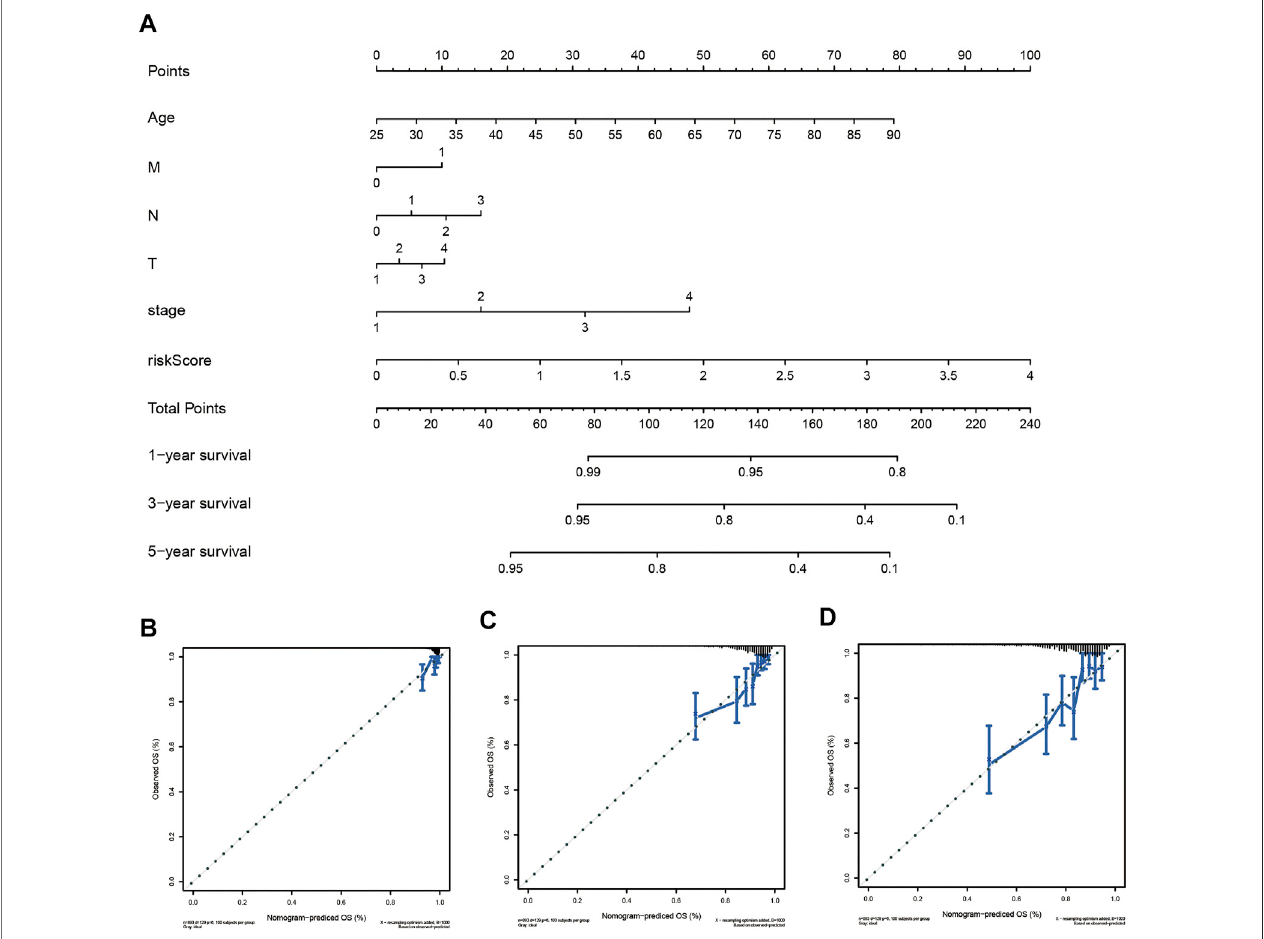
FIGURE 7 | Establishment of the prognostic nomogram to predict overall survival of breast cancer patients based on TCGA cohort (A) The nomogram for predicting survival proportion of patients in 1-, 3-, and 5-year. (B – D) The calibration plots for predicting patient survival at1-, 3- and 5-years.